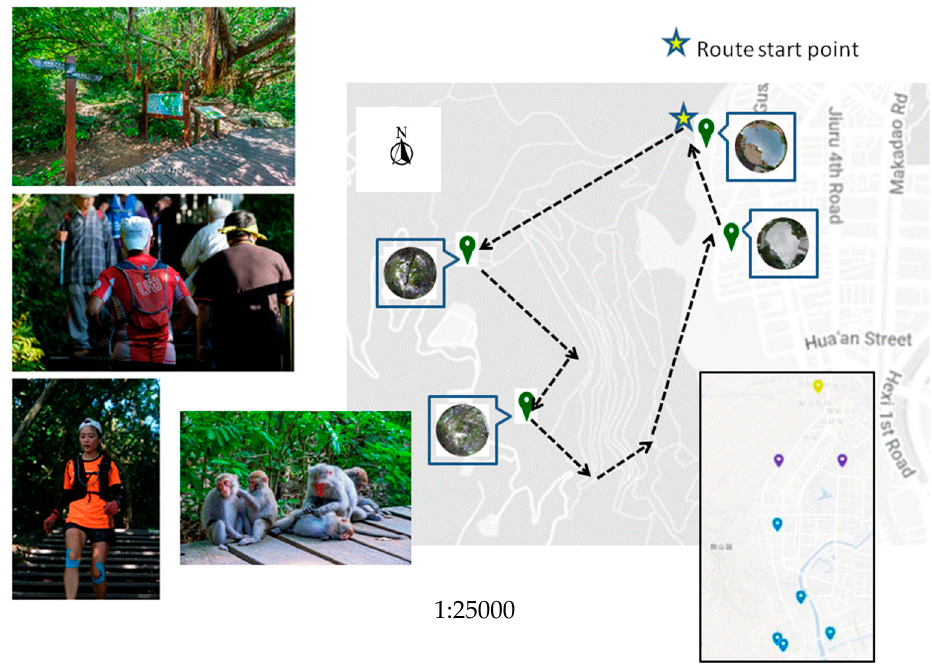
Figure 8. Autumn running event route, activity photos, and fisheye photos.